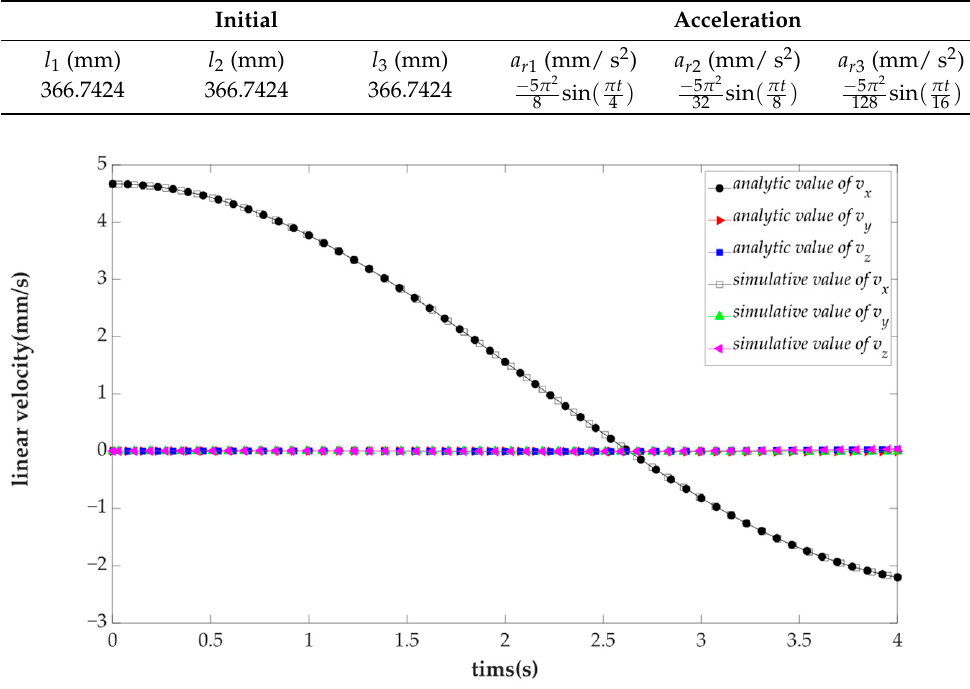
Figure 10. The comparison between analytic results and simulative results of linear velocity of m .